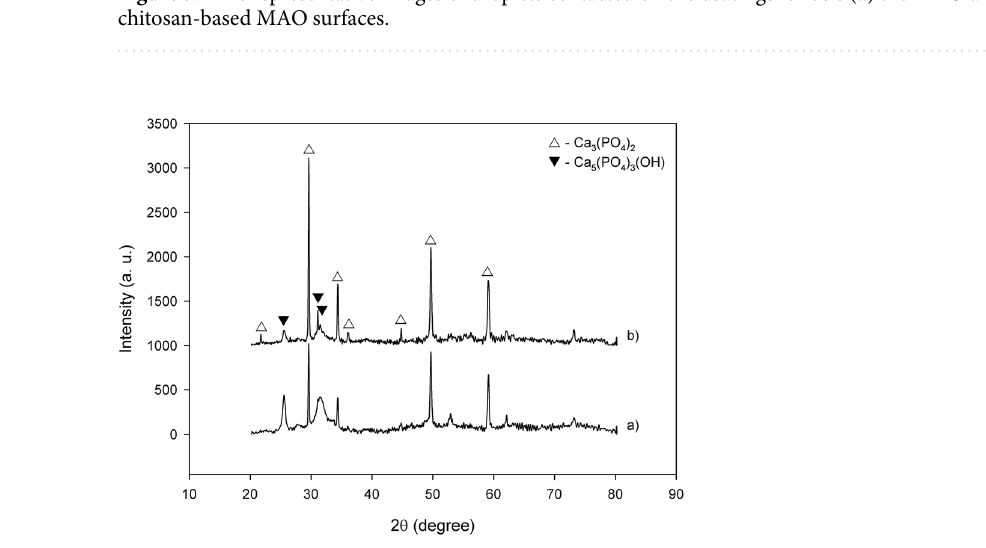
Figure 6. XRD spectra of the coatings at post-immersion in SBF: ( a ) the MAO and ( b ) chitosan-based MAO